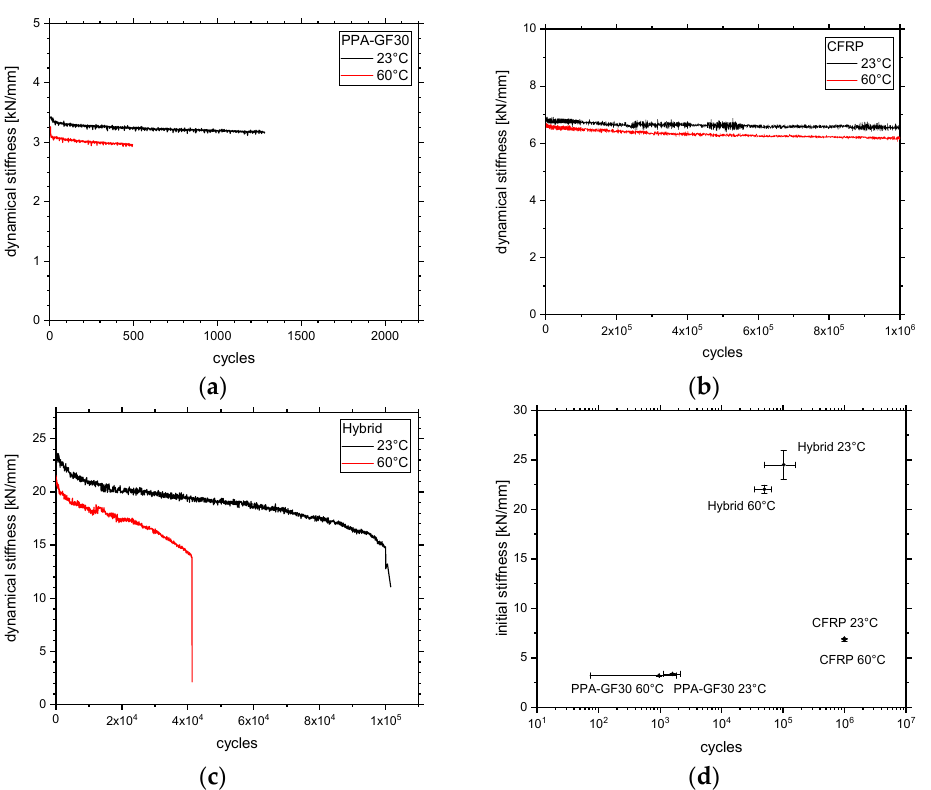
Figure 9. Results from dynamical testing for ( a ) PPA-GF30, ( b ) CFRP, and ( c ) hybrid specimens; ( d ) mean values of initial stiffness and cycles to failure. Table 3. Comparative analysis at the two different testing temperatures. The stop criterium is 1,000,000 cycles.